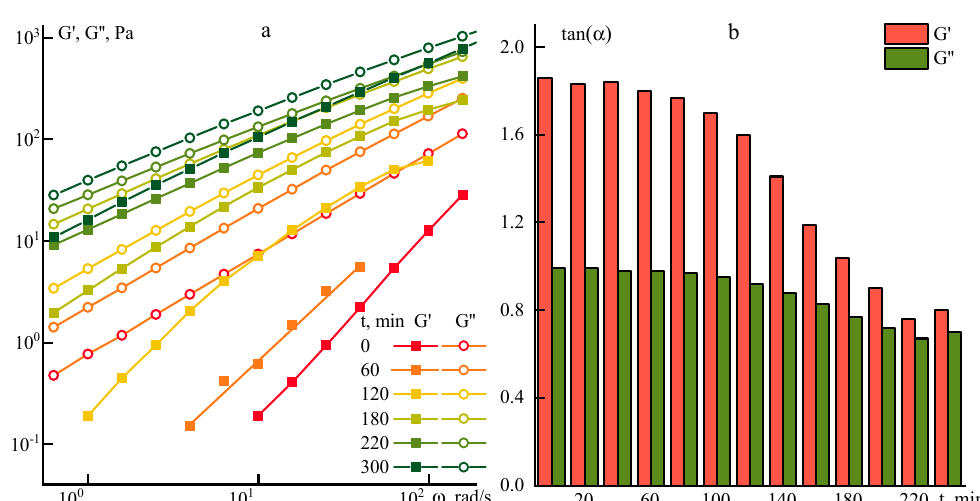
Figure 4. ( a ) Frequency dependences of the viscoelastic characteristics and ( b ) the kinetics of slopes change of the storage and loss moduli frequency dependences at 70 °C for a 10% P2 solution after different heating times at 70 °C.